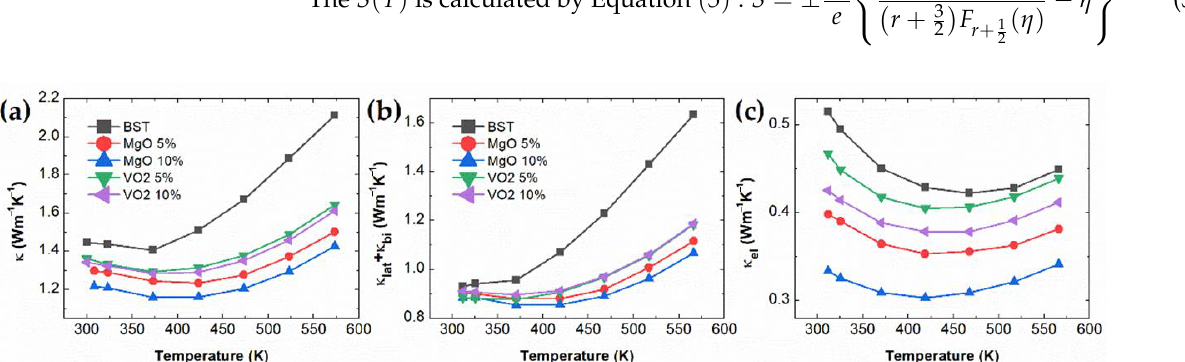
Figure 3. Temperature-dependent ( a ) total thermal conductivity κ ; ( b ) lattice and bipolar thermal conductivity κ L + κ bi ; ( c ) electronic thermal conductivity κ el of MgO and VO 2 BST composites.